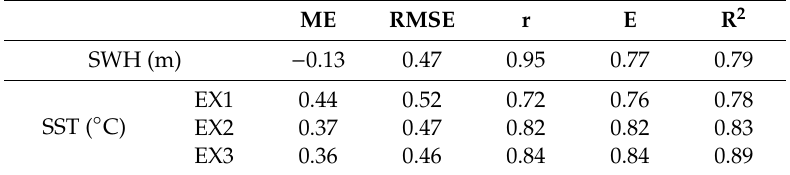
Figure 2. Scatter diagrams (a) the color means the number of data in logarithmic form and error probability distribution ( b ) of the SWH for the year 2016 in the computational domain. Table 2. Comparisons of the SWH and SST between the observations and model results.